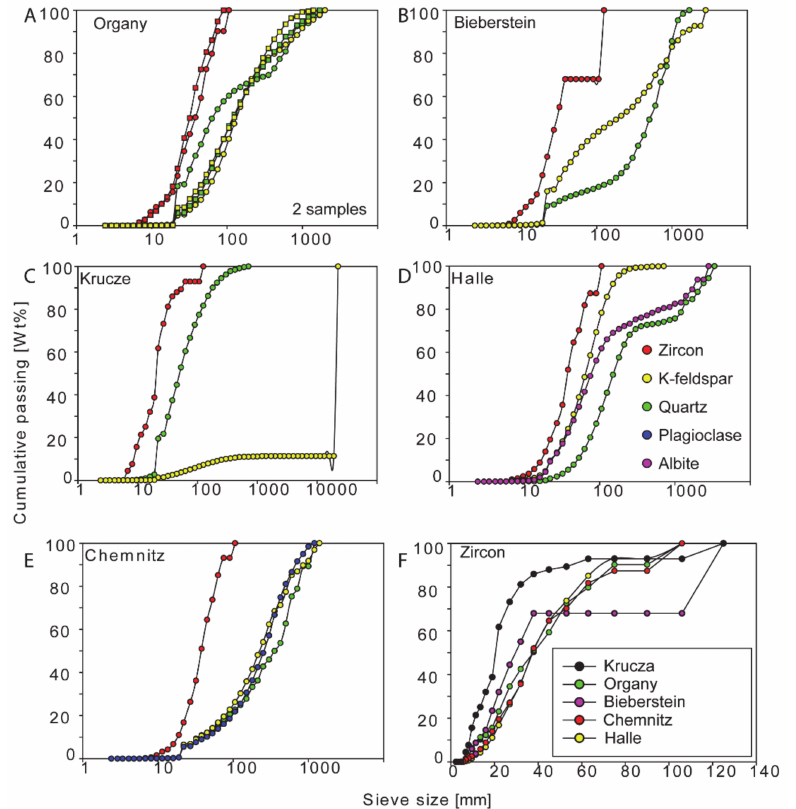
Figure 6. Grain size distribution for major minerals in each locality ( A – E ) as well as a comparison of zircon grain size distribution in di ff erent localities ( F ). Data are from MLA. Please note that in Krucze ( C ) fine-grained K-feldspar was recognized as a single grain by the